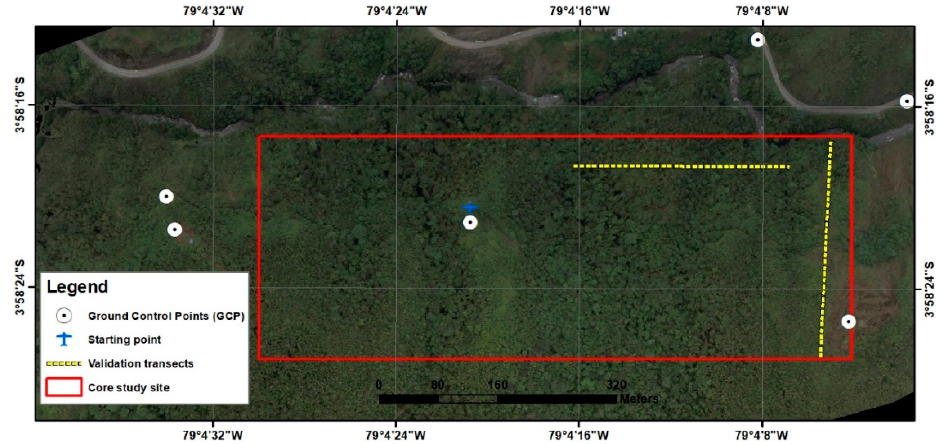
Figure 3. Drone-based orthophoto of the selected study area, including the starting point, ground control points (GCP), and validation transects (yellow) inside the core area (rectangle).